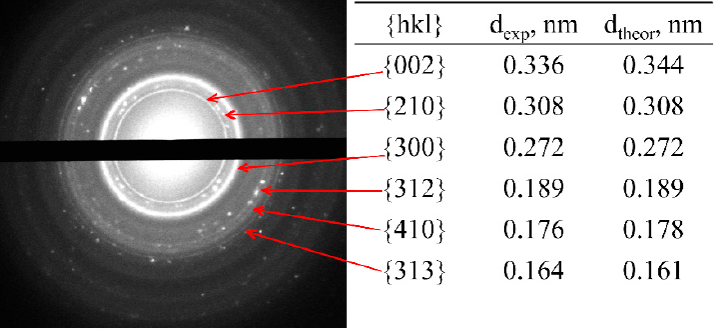
Figure 6. ( left ) Electron diffraction pattern of the sample 1 (Table 1). ( right ) Corresponding experi- mental ( d exp ) and theoretical ( d table ) [69] interplanar spacings.